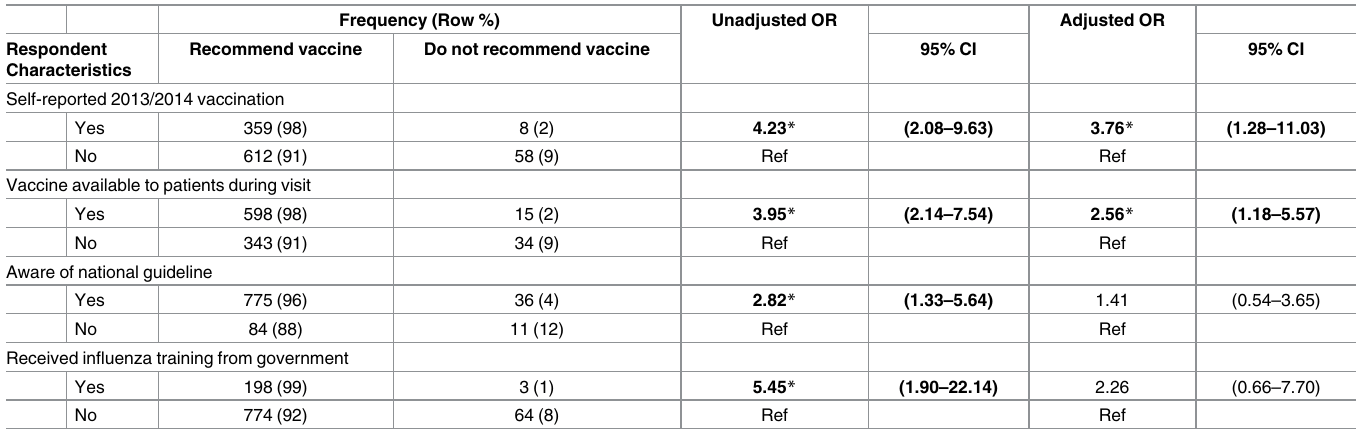
Table 4. Characteristics among South African healthcare workers recommending influenza vaccine to HIV-infected patients ±